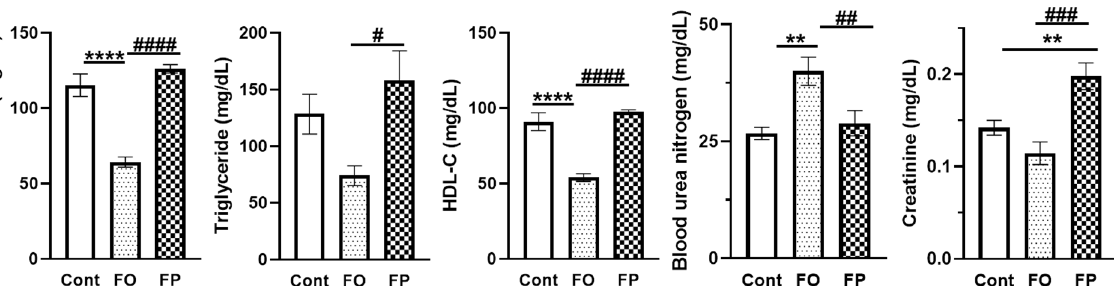
Figure 1. Effects of a diet containing fish oil (FO) or fish protein (FP) on serum biochemical param- eters in a senescence-accelerated mouse model at 6 months of age. All data are presented as the mean ± standard error of the mean ( n = 10 mice for control and FP, n = 7 for FO). ** p < 0.01, **** p < 0.0001 vs. control diet group (Cont = control), # p <0.05, ## p < 0.01, ### p < 0.001, #### p < 0.0001 vs. FO diet group. HDL-C = high-density lipoprotein